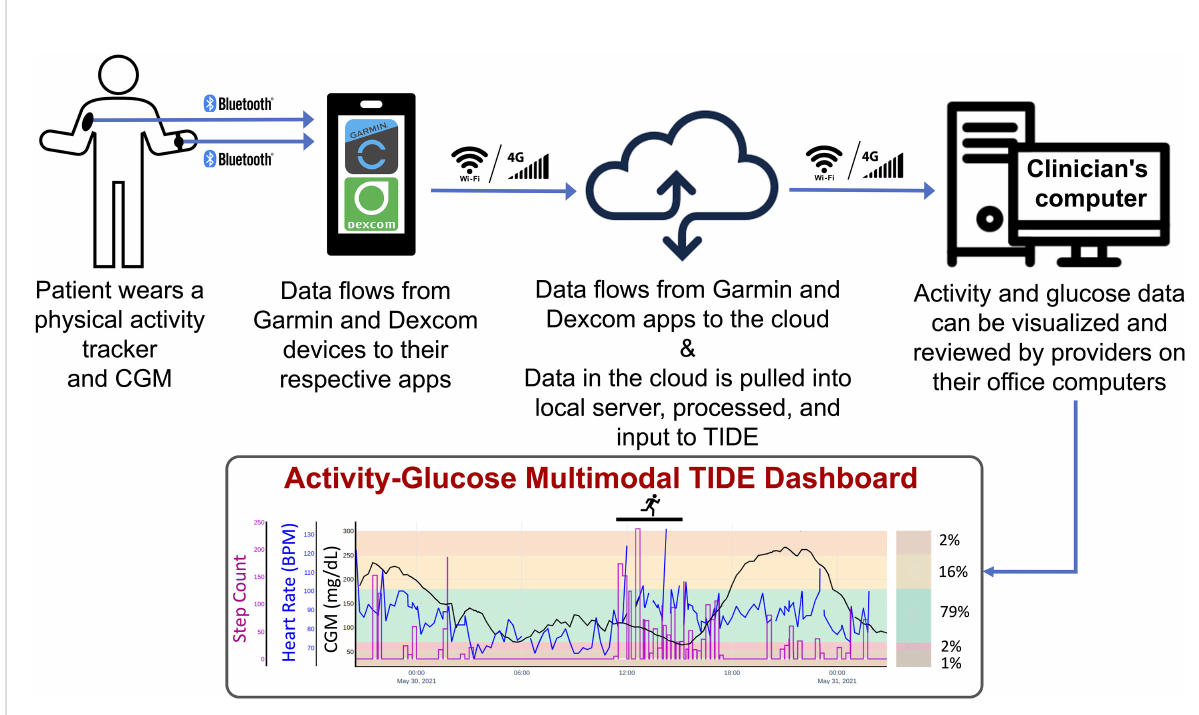
FIGURE 1 Multimodal decision-support Timely Interventions for Diabetes Excellence (TIDE) care model integrating continuous glucose monitoring (CGM) and physical activity (Garmin Vivosmart 4 or Venu Sq)